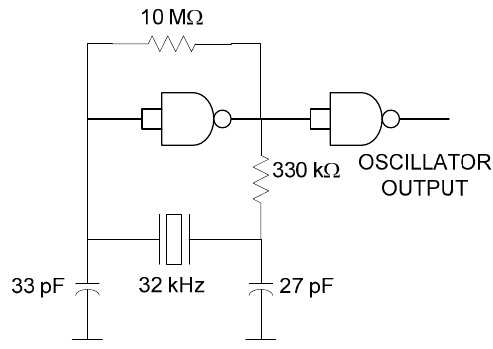
Figure 4. Schematic of the quartz crystal low-power oscillator.